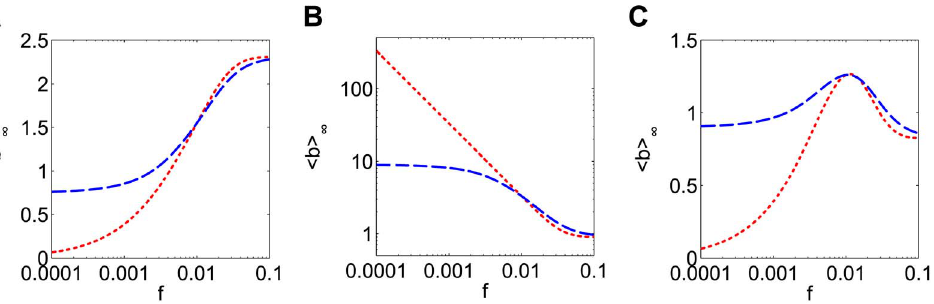
Figure 7. The ab-model displays the responses predicted by the nonlinear production rate function. The model has increasing ( A ), decreasing ( B ) and bell-shaped ( C ) responses when the production rate function is sublinear, superlinear, and sigmoidal, respectively. Frequency responses for amplitude compensated signals and duration compensated signals are shown in red (dotted curve) and blue (dashed curve), respectively. A 0 =3 and d 0 =10 at frequency f 0 =0.01.